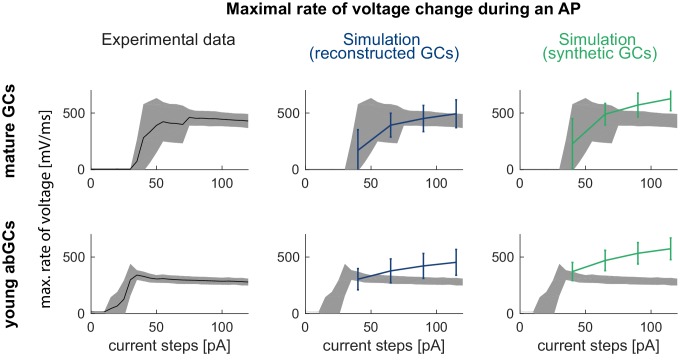
Maximal rate of voltage change during an AP in the mature mouse GC model.The maximal voltage deflection during a spike shows a sudden jump and then slow decay in the experiment when current amplitudes are increased in mature (upper row, left) and young GCs (lower row, left) which is not reproduced in the mature/young GC model with the na8st sodium channel model (from Schmidt-Hieber and Bischofberger, 2010) in reconstructed (middle column) or synthetic (right column) morphologies.